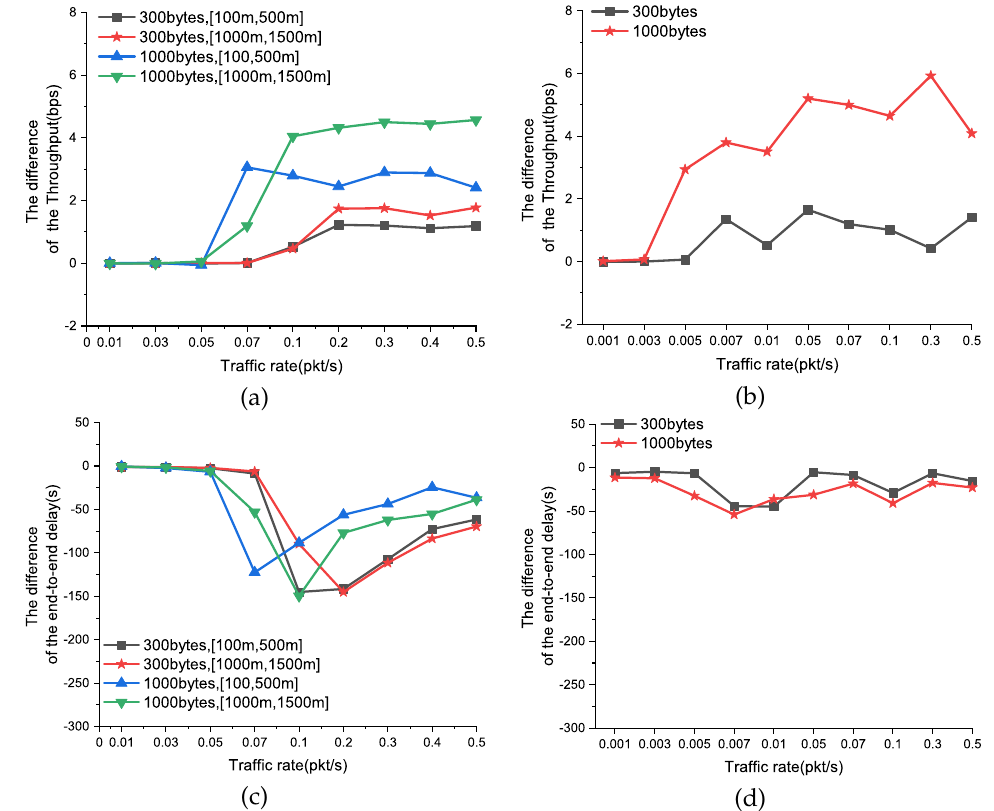
Figure 12. The performance of SFLC–MAC and SFNW–MAC in relation to the traffic rate. ( a ) The difference of the throughput in 4–Node topology. ( b ) The difference of the throughput in 16–Node topology. ( c ) The difference of the end–to–end delay in 4–Node topology. ( d ) The difference of the end–to–end delay in 16–Node